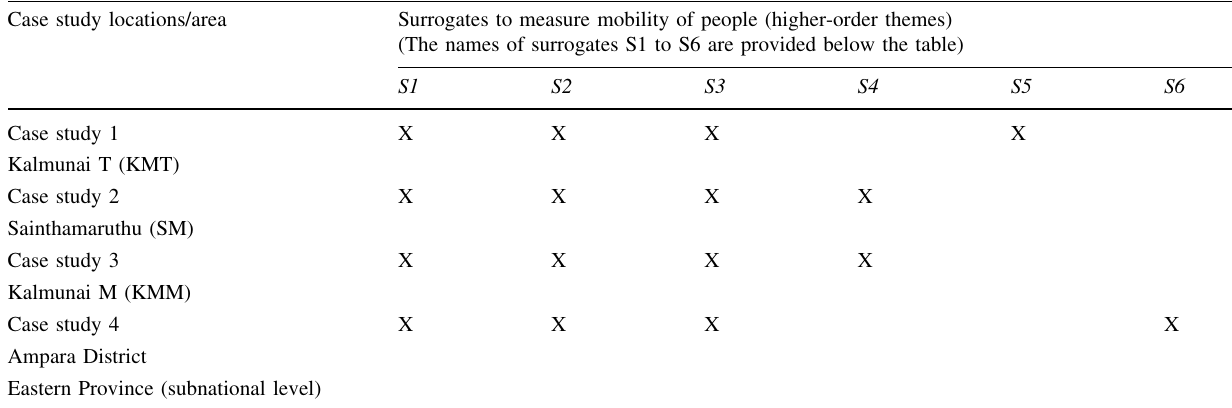
Table 3 Surrogates (higher-order themes) mapping against individual case studies Case study